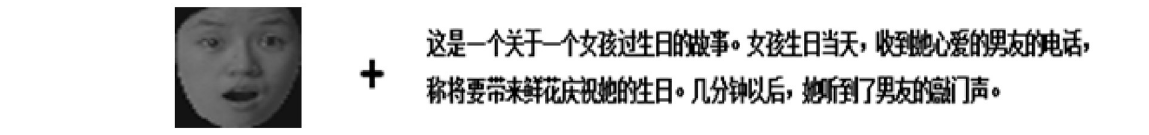
FIGURE 1 | Example of a trial on the face–vignette task. The situational vignettes in English are as follows: This is a story about a girl’s birthday. The girl stayed in her room. She received a call from her beloved boyfriend: “You’re waiting for me at home. I’ll bring your favorite flowers to your birthday!” Several minutes later, she heard the knock of her boyfriend’s arrival. The question was “What emotion is the person feeling?” Responding with “surprise” will be recorded as a face response and responding with “hopeful” will be recorded as a vignette response. Additionally, any other response will be recorded as a random response.